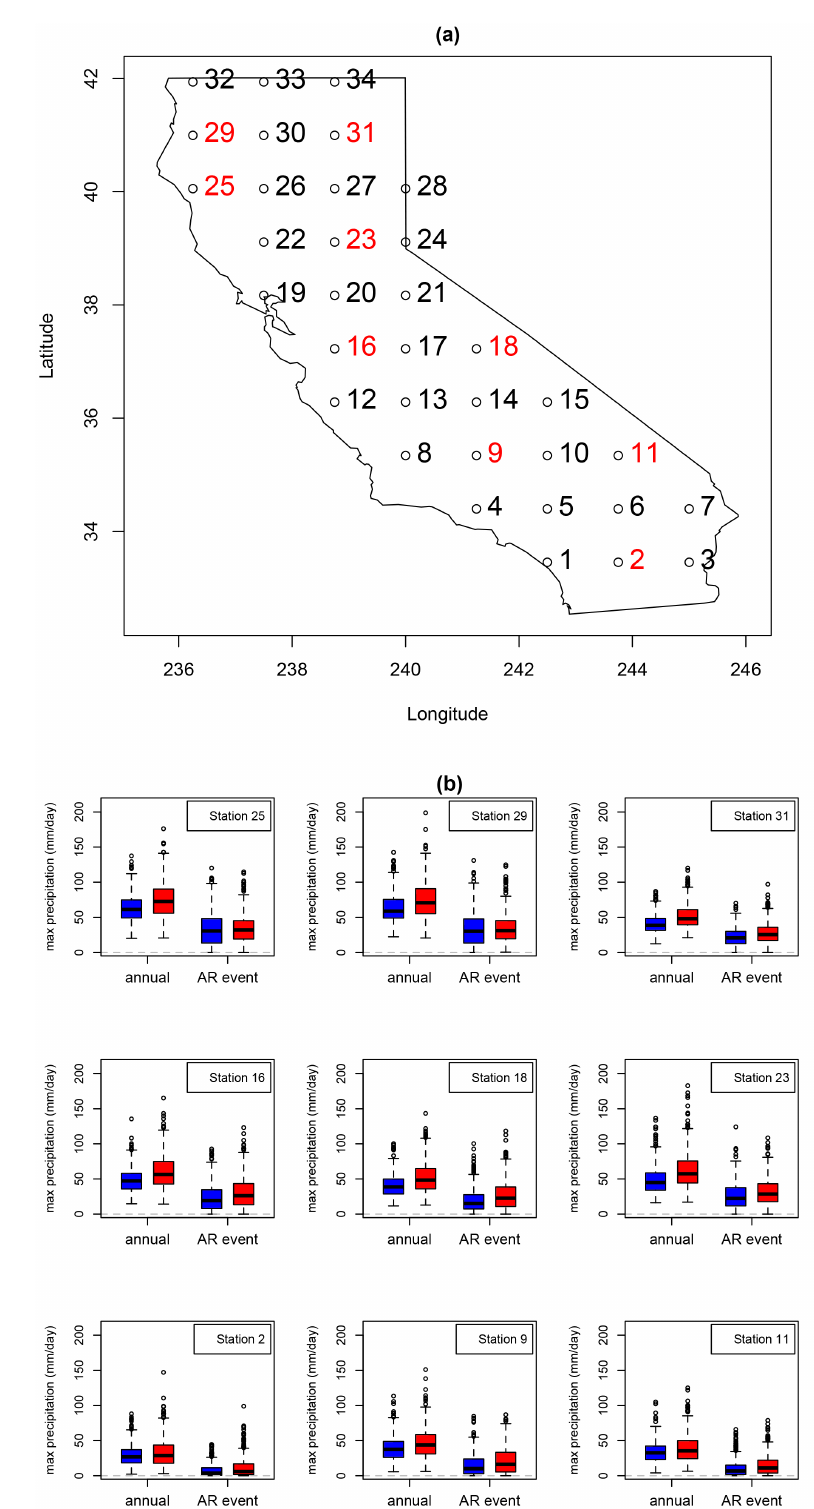
Figure 5. (a) Grid points of CMIP5 models in California, USA, and (b) boxplot summaries of annual maximum precipitation (left pair of box and whiskers at each indicated grid point) and maximum precipitation within AR events (right pair of box and whiskers at each indicated grid point) during 25-year time periods at nine grid points in California. Blue and red boxplots represent the historical and RCP8.5 runs, respectively, and the station numbers are used to identify grid points in red (a)